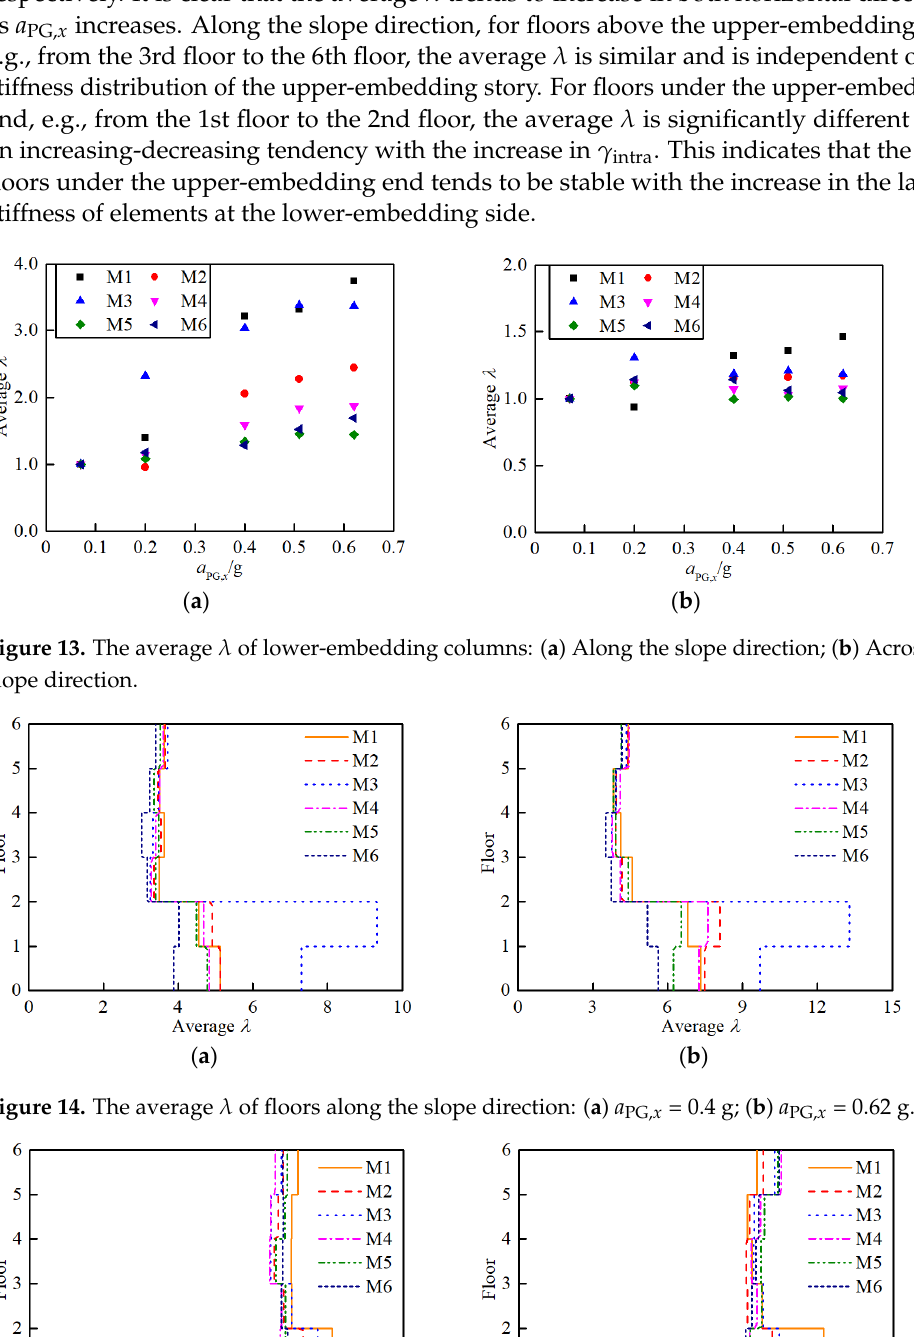
Table 6. The average proportion of base shear across the slope direction is borne by lower ‐ embed ‐ ding columns.